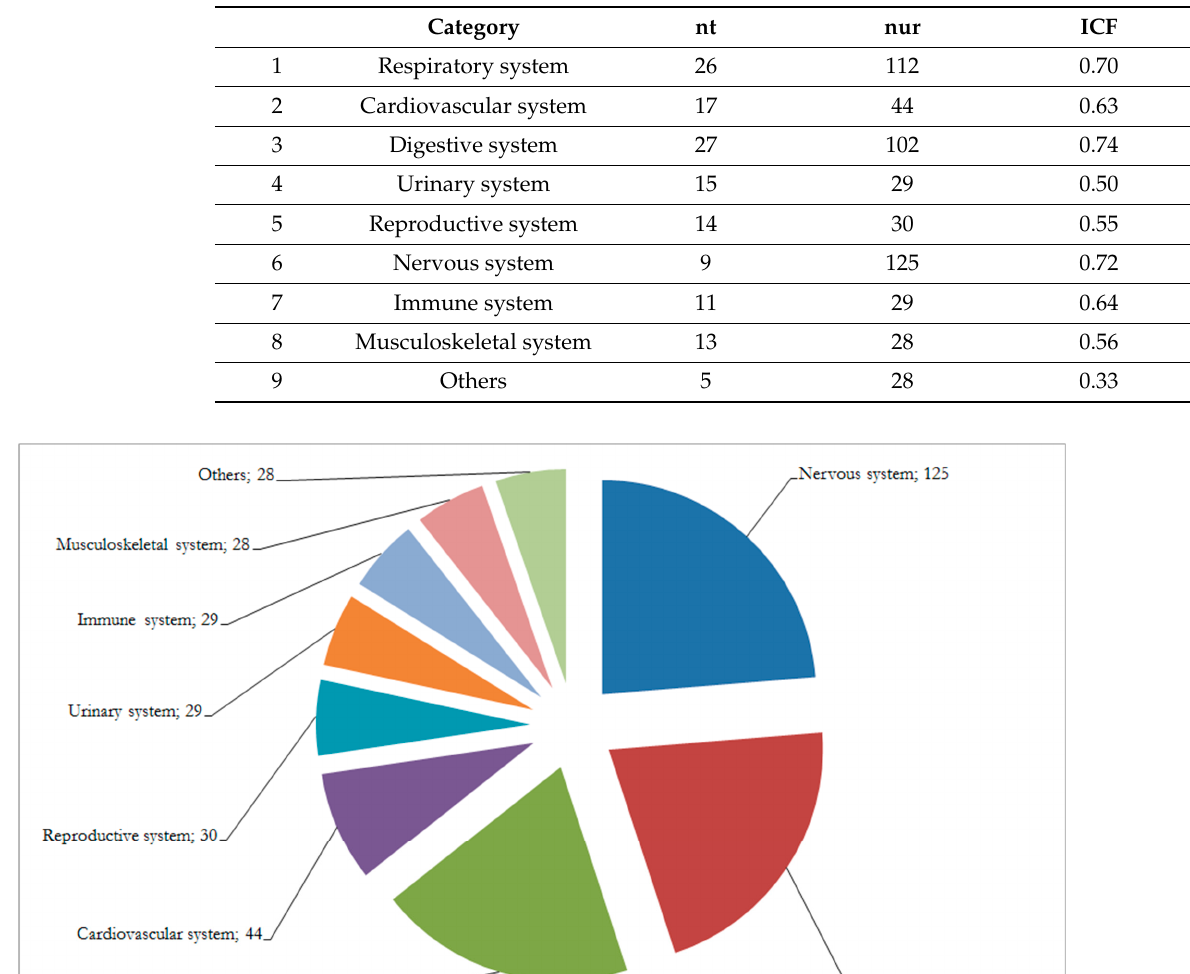
Table 2. ICF factor by diseases categories for Central Rhodopes .